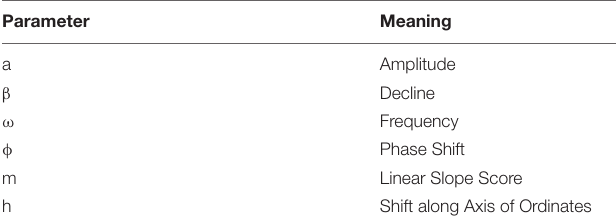
TABLE 4 | Parameter description of the dampened harmonic